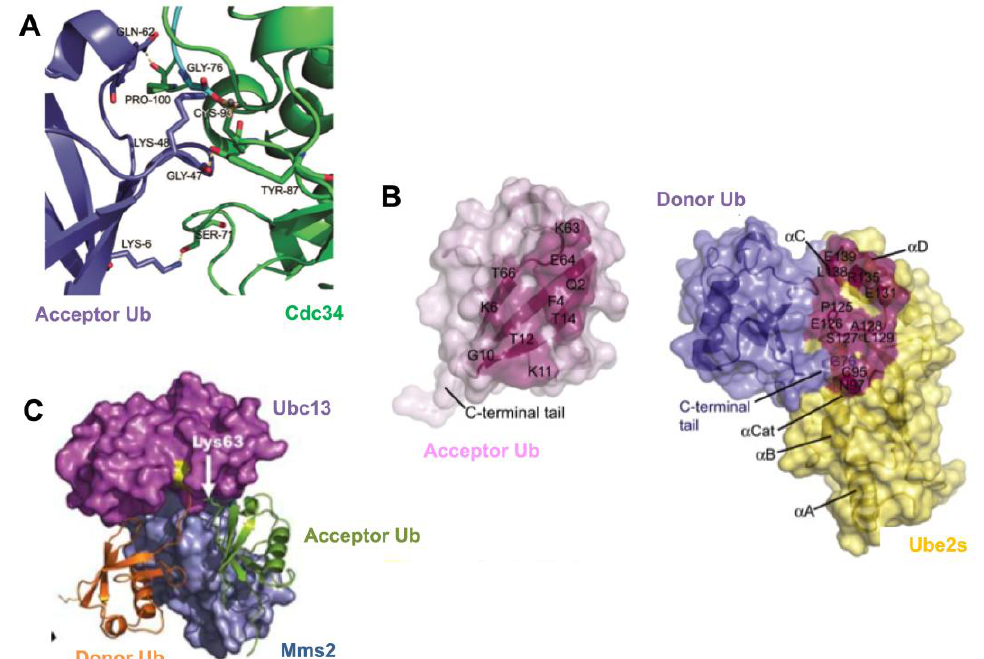
Figure 2. Mechanisms for generating lysine-specific poly-Ub